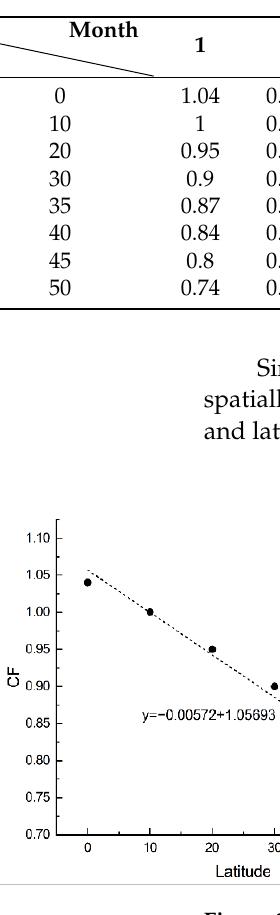
Table 1. CF values by month at different latitudes.